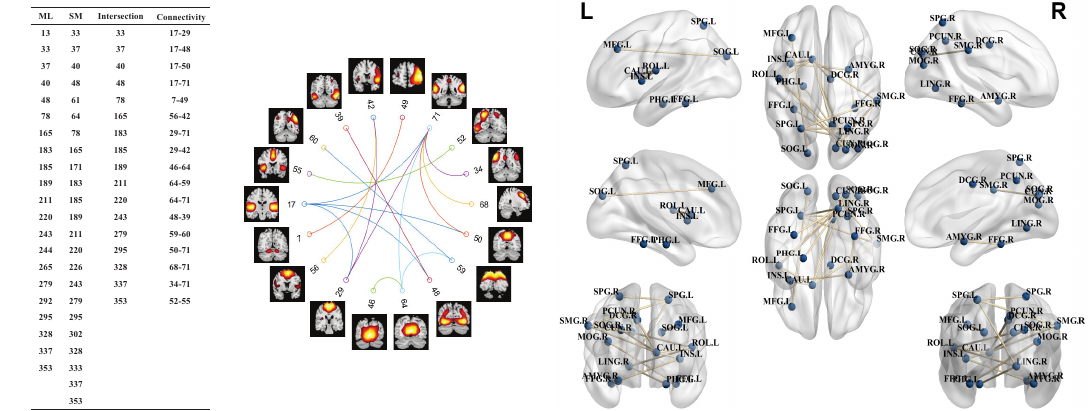
Figure 9. The abnormal functional connections of brains with SZ. In this figure, the left table lists the selected abnormal functional connections of the regions of interest (the relationships of the regions and the labels are shown in Figure A2), in which ML refers to machine learning methods and SM refers to statistical methods. The circular connectivity graph in the middle is a schematic map of the selected functional connections, which are listed in the fourth column of the left table. The labels in this graph correspond to the regions of interest, and the corresponding spatial maps of these regions (see [48]) are also shown in this graph. The right graph depicts the locations and their connections of the selected brain regions by the BrainNet Viewer toolbox